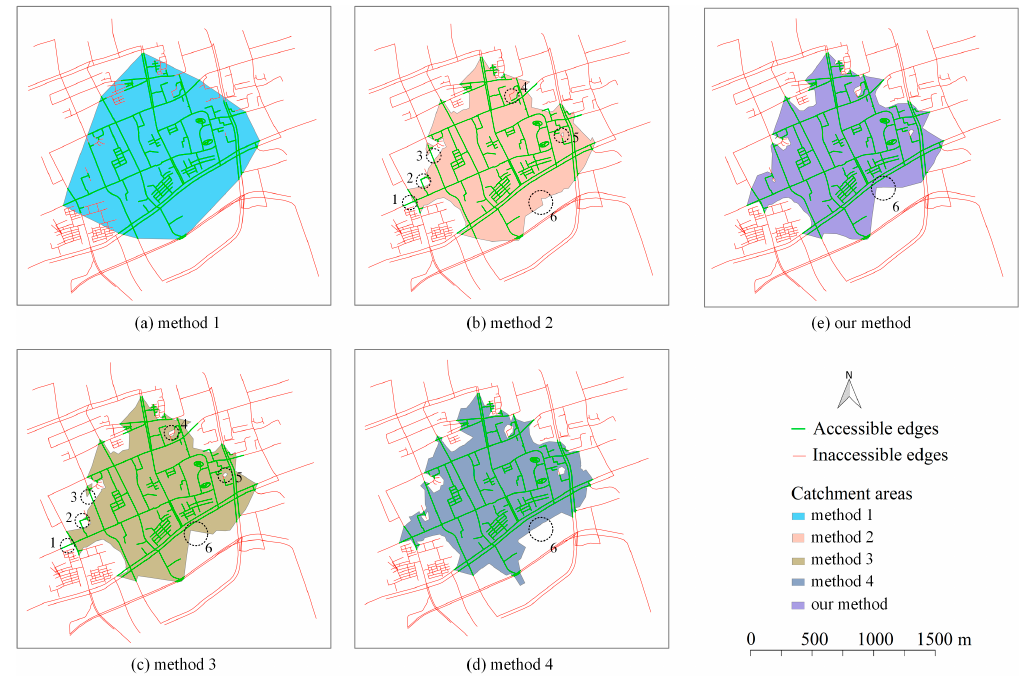
Figure 11. The catchment areas generated by five different methods.